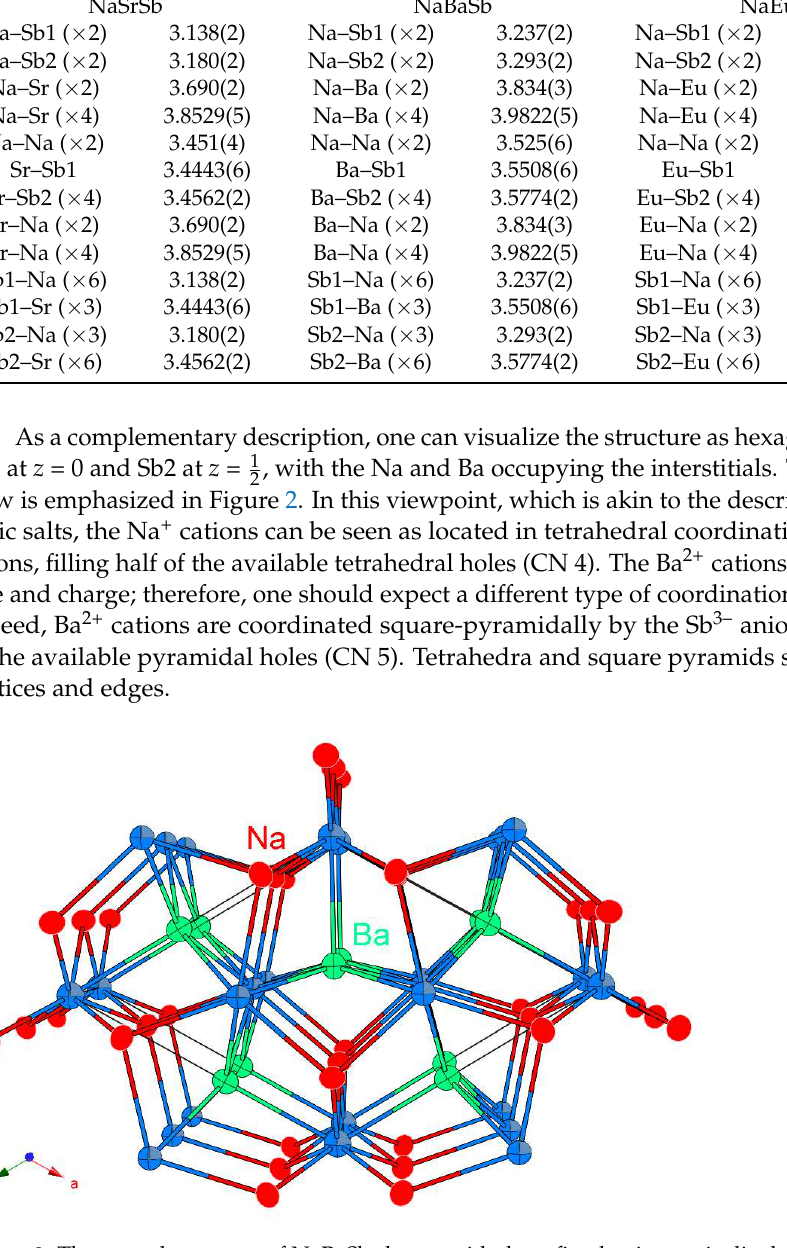
Figure 2. The crystal structure of NaBaSb shown with the refined anisotropic displacement parameters for all atoms (95% probability level). The Ba atoms (light green) are coordinated to five Sb atoms (light blue) in a square-pyramidal fashion. The Na atoms (red) are tetrahedrally coordinated to four Sb atoms.